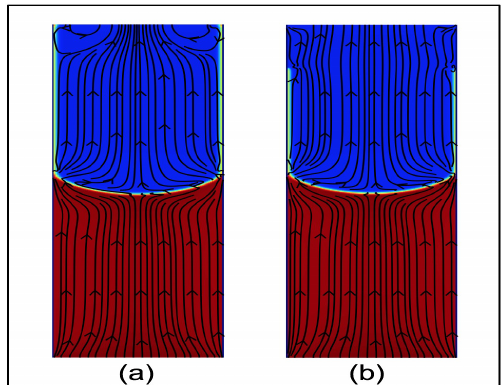
Figure 15. The steady-state density profile (red for liquid and blue for vapor) and streamlines in two cases: ( a ) the solid wall is purely hydrophilic (contact angle is about 15 ◦ ); ( b ) the top section of the solid wall is hydrophobic (contact angle is about 145 ◦ , section length is 50 ∆ x ) while the remaining part of the wall is still